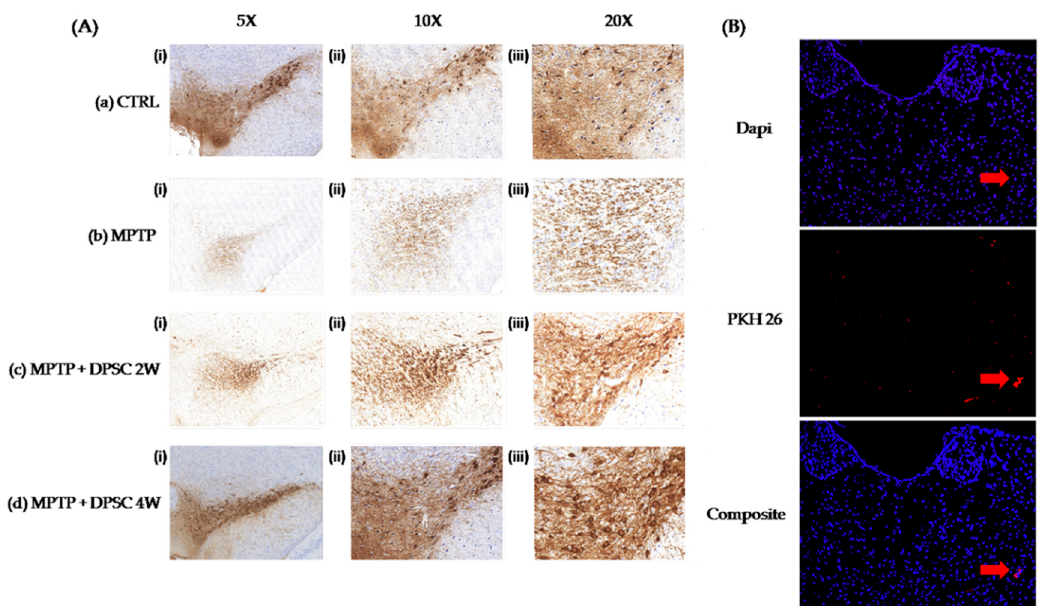
Figure 5. ( A ) Pictures displaying the effects of MPTP and intranasally administered DPSCs on tyrosine hydroxylase (TH) expression in the substantia nigra pars compacta (SNpc) of MPTP induced mice. (i–iii) Photomicrographs showing TH expression within the SNpc at low (5 × ), medium (10 × ) and high magnification (20 × ). ( a ): Control group at day 0 ( b ): Vehicle group: MPTP + saline at Day 7 ( c ) Treatment group: MPTP + DPSCs (two weeks after DPSC delivery) ( d )Treatment group: MPTP + DPSCs (four weeks after DPSC delivery). The DPSCs labelled with PKH26 were delivered to MPTP mice at Day 7. Mice were lesioned with MPTP at Day 0. ( B ) Survival and migration of the PKH-labelled DPSCs within the SNpc following intranasal administration. PKH26 fluorescence visualization proved the existence of cell deposits in the SN (red arrow) of all grafted animals, indicating cell survival for at least four weeks after intranasal delivery (photomicrographs at high (20 × ) magnification).